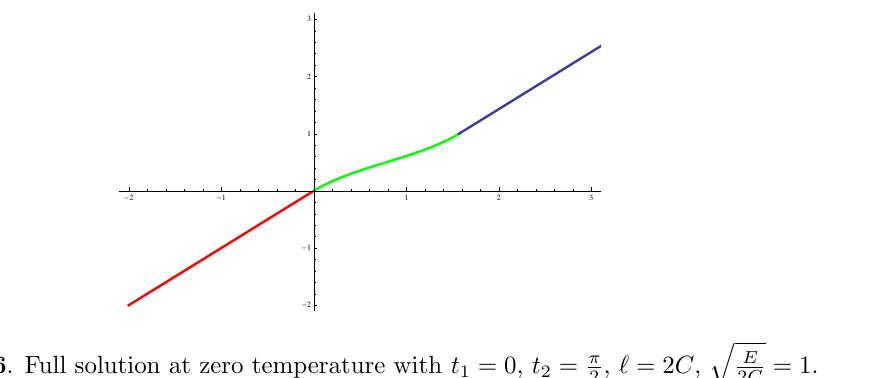
Figure 5 . Full solution with non-zero temperature, with (cid:28) 1 = 0, ‘ = 2 C , k 2 = 1, k 1 = 3, with saddle values (cid:28) 2 (cid:25) 0 : 236, (cid:28) f (cid:25) 1 : 588 and (cid:12) (cid:25) 3 : 159.